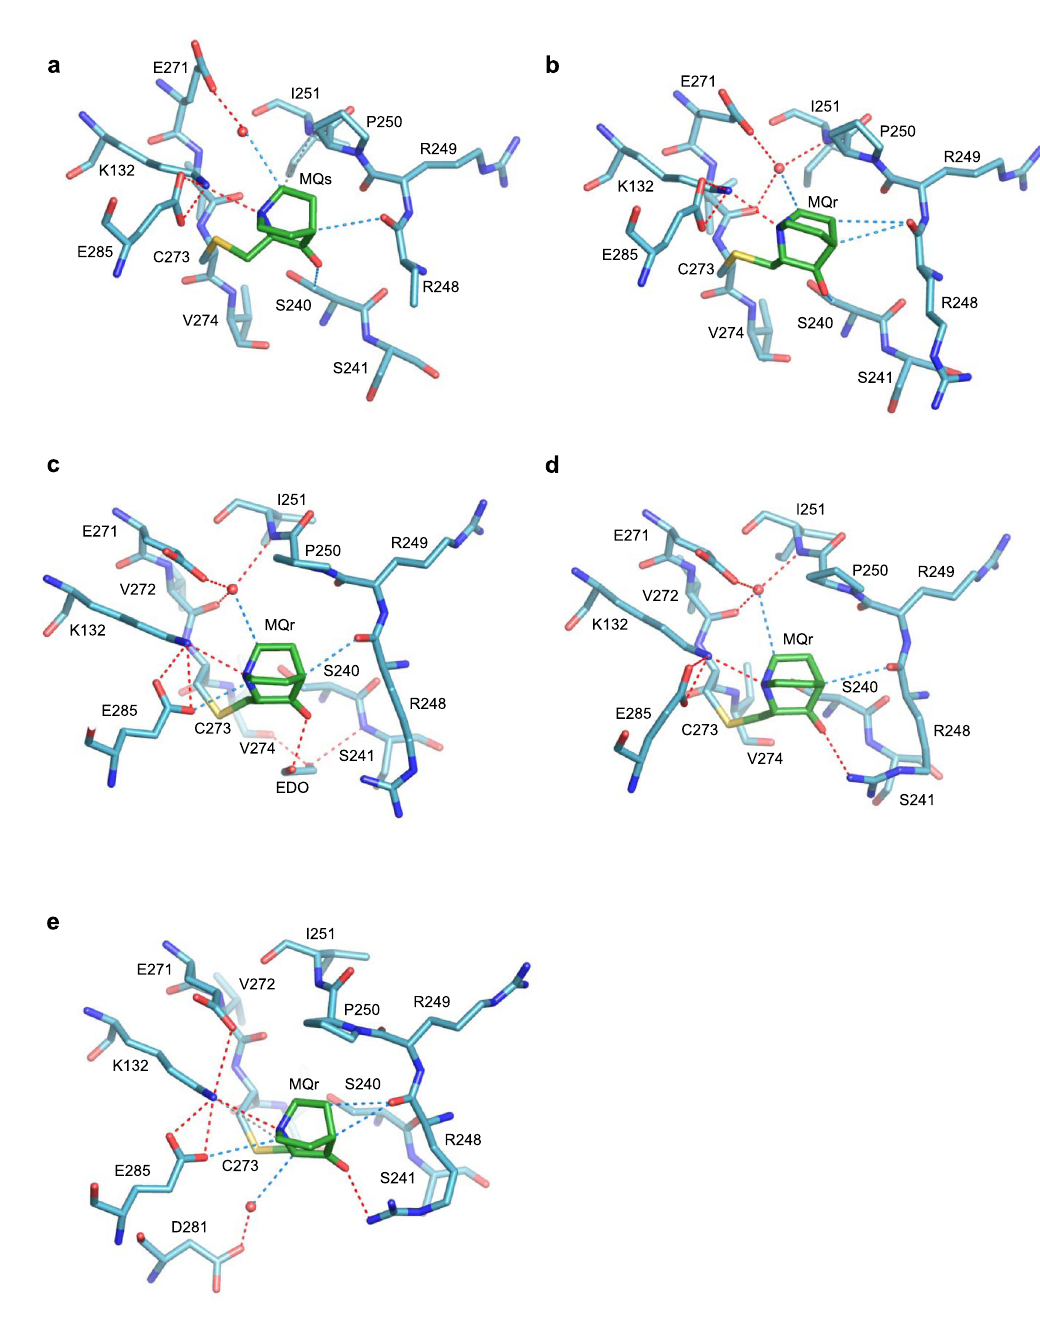
Fig. 5 MQ bound to C273 in R273C mutants. The MQ-C273 conjugates and intramolecular interactions are from the following crystal structures. a R273C- MQ (I), monomer B. b R273C-MQ (I), monomer D. c R273C-MQ (II), monomer A (EDO refers to ethylene diol). d R273C-MQ (II), monomer B. e R273C- MQ (II), monomer C. All MQ-C273 conjugates are similarly located in a shallow depression at the p53 surface and supported by polar interactions with the surrounding residues. Structure representations and color codes are as in Figs. 1 –